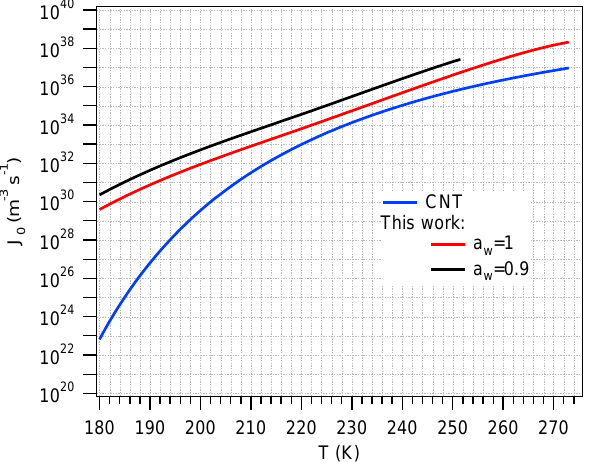
Figure 3. Preexponential factor using the common form of CNT (Sect. 2.3) and the model presented in this work, Eq. (11). For CNT the formulation of Zobrist et al. (2007) was used to calculate (cid:49)G act .